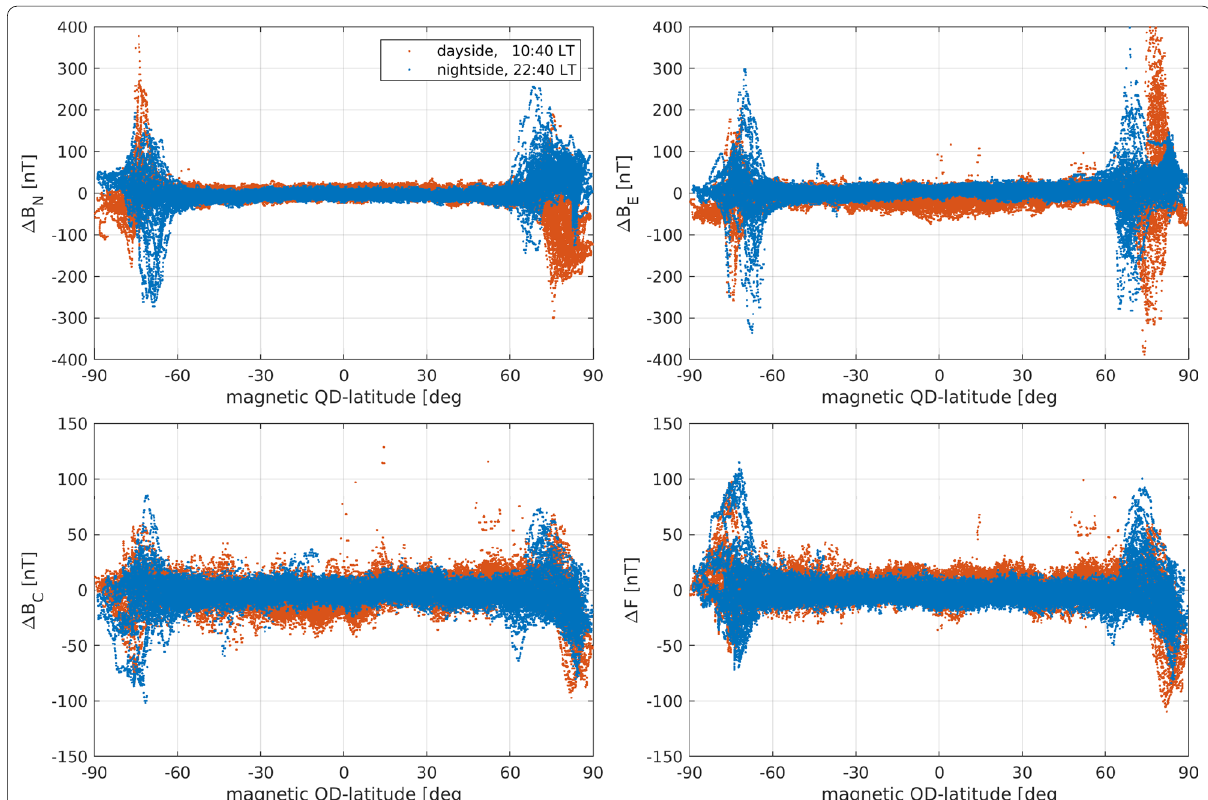
Fig. 10 Difference between observed magnetic field and CHAOS-7 model predictions in dependence on QD latitude, for 10 to 19 August 2010 as measured by the GRACE-A satellite and for dayside (10:40 LT) and nightside (22:40 LT) parts of the orbits,